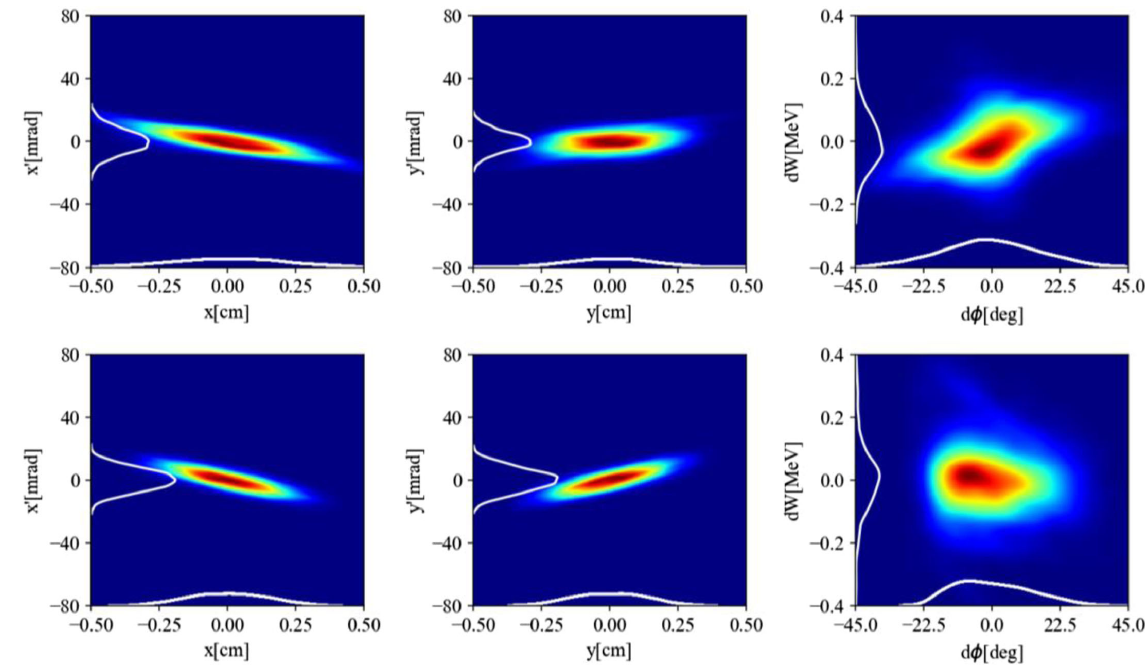
FIG. 14. Particle distributions at the MEBT output (top graphs) and at the RFQ 2 output (bottom